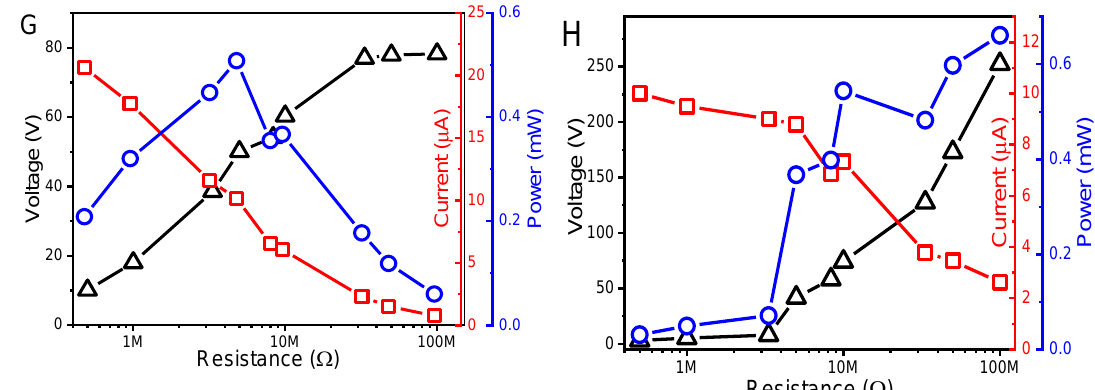
Figure 3. Triboelectric output voltage, current and power as a function of the load resistance for di ff erent material pairs: ( A ) PA66:SEBS; ( B ) PA66:PP; ( C ) Mica:SEBS; ( D ) Mica:PVDF-c; ( E ) Mica:PVDF; ( F ) Mica:30BT / PVDF; ( G ) Mica:Kapton and ( H ) Mica:PU. Table 2. Summary of the output power, voltage and current for the di ff erent systems under evaluation, the larger output powers being for the PA66:PP and the Mica:30BT / PVDF